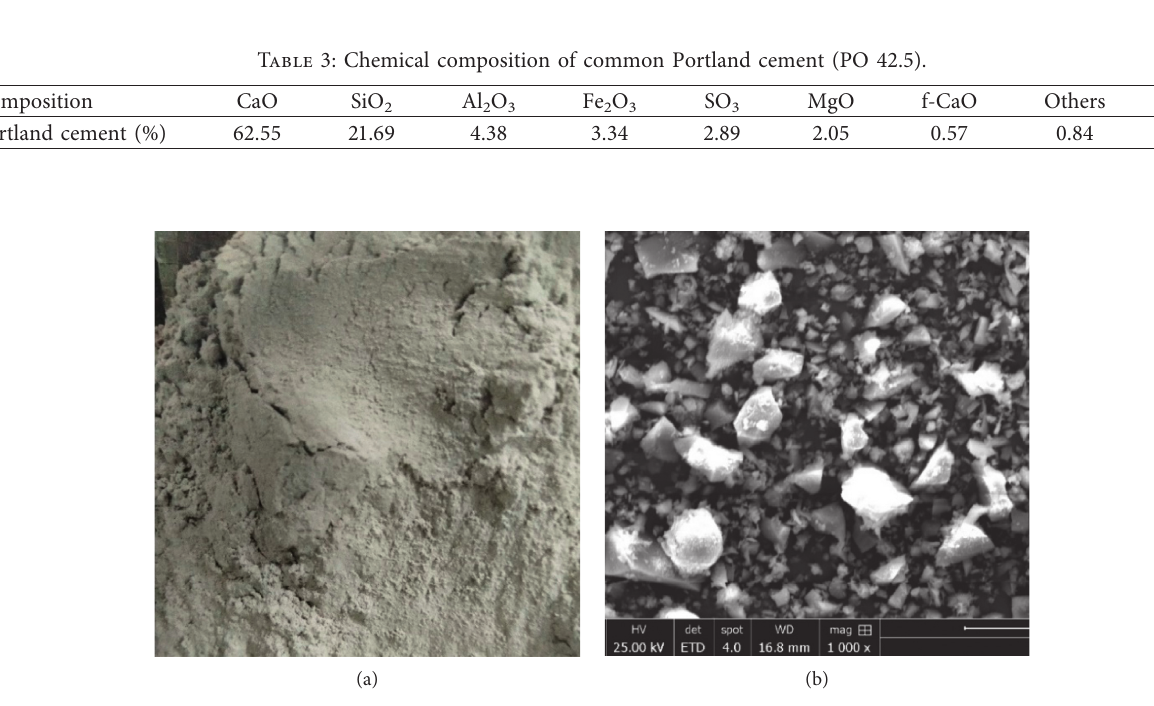
Figure 1: Compound ferronickel slag powder. (a) Appearance of compound. (b) SEM image of compound. Table 4: The main salt content of seawater.